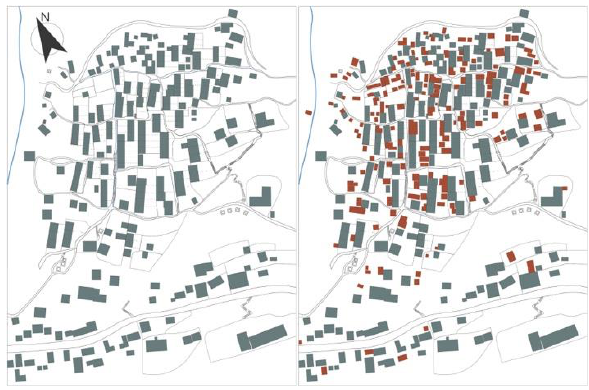
Figure 4. Left map - Gatlang traditional houses – Right Map. 2016- Gatlang traditional houses and makeshift dwelling marked in red. 2019 (Authors).